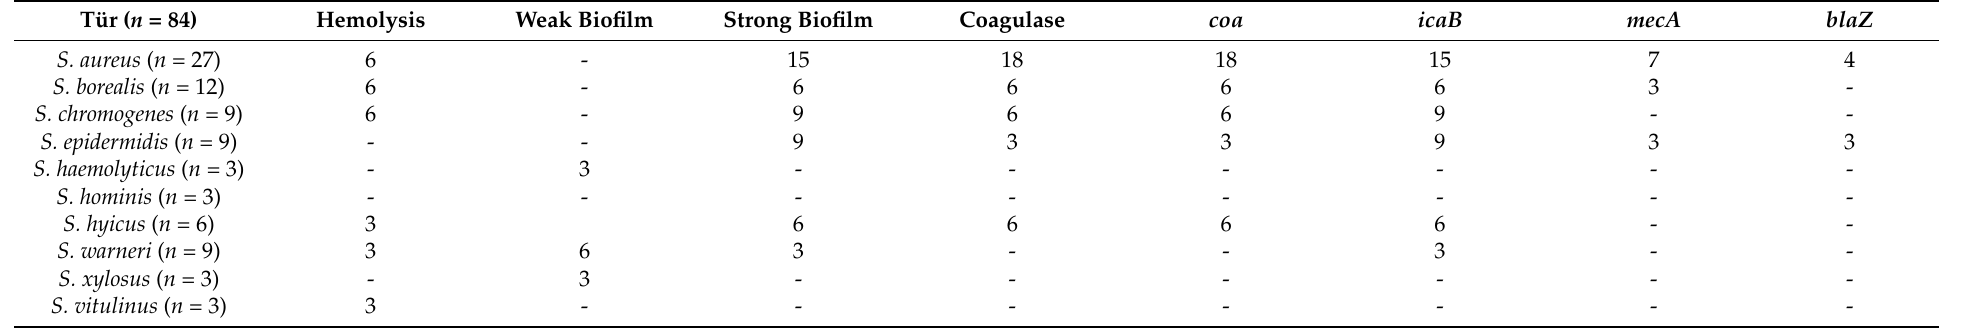
Table 2. Number of isolates with positive test results.